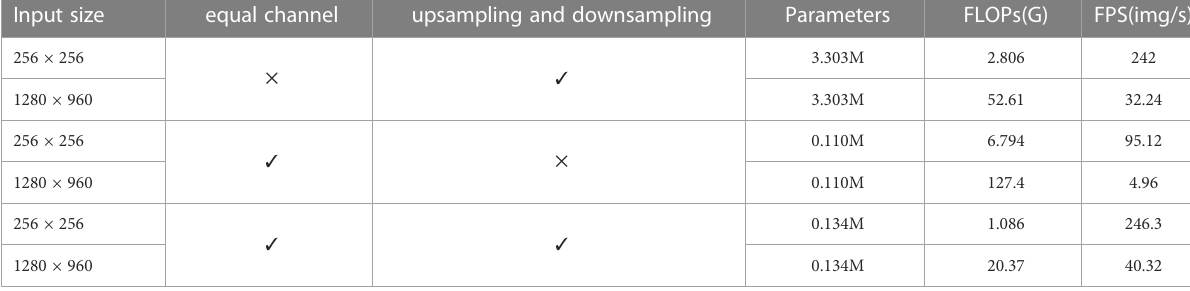
TABLE 10 Comparison of upsampling and downsampling operations during underwater video